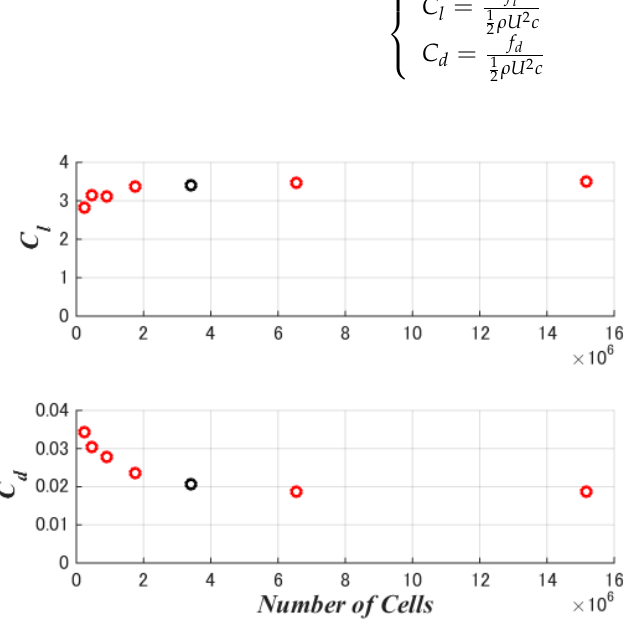
Figure 3. Lift and drag coefficients to numbers of cells (black: 3.4 million).